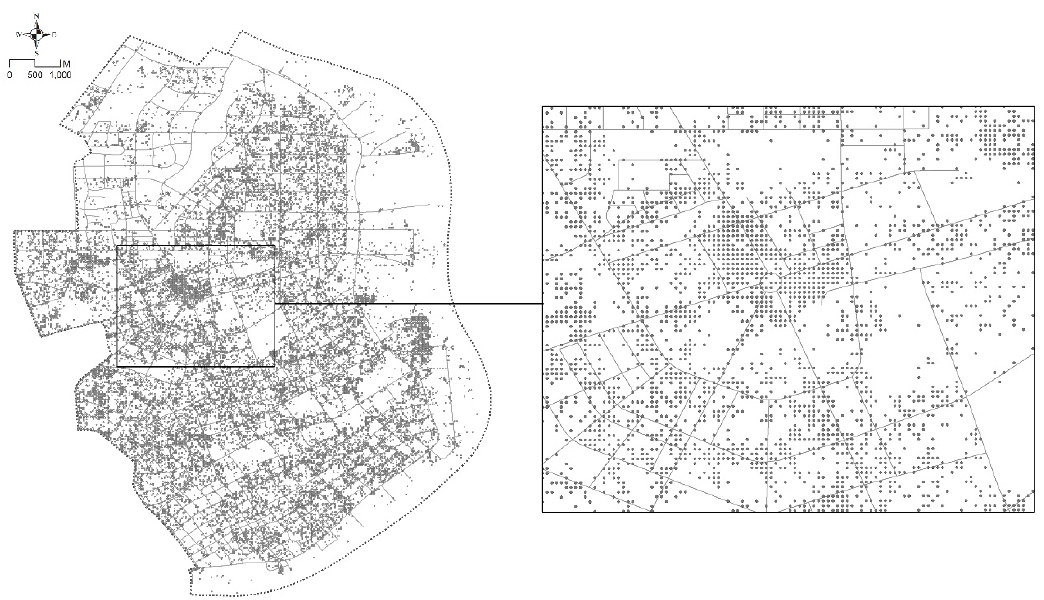
Figure 3. Example of location-based service (LBS) data on a weekend (10 p.m.) from Tencent (collected on 16th December 2018).